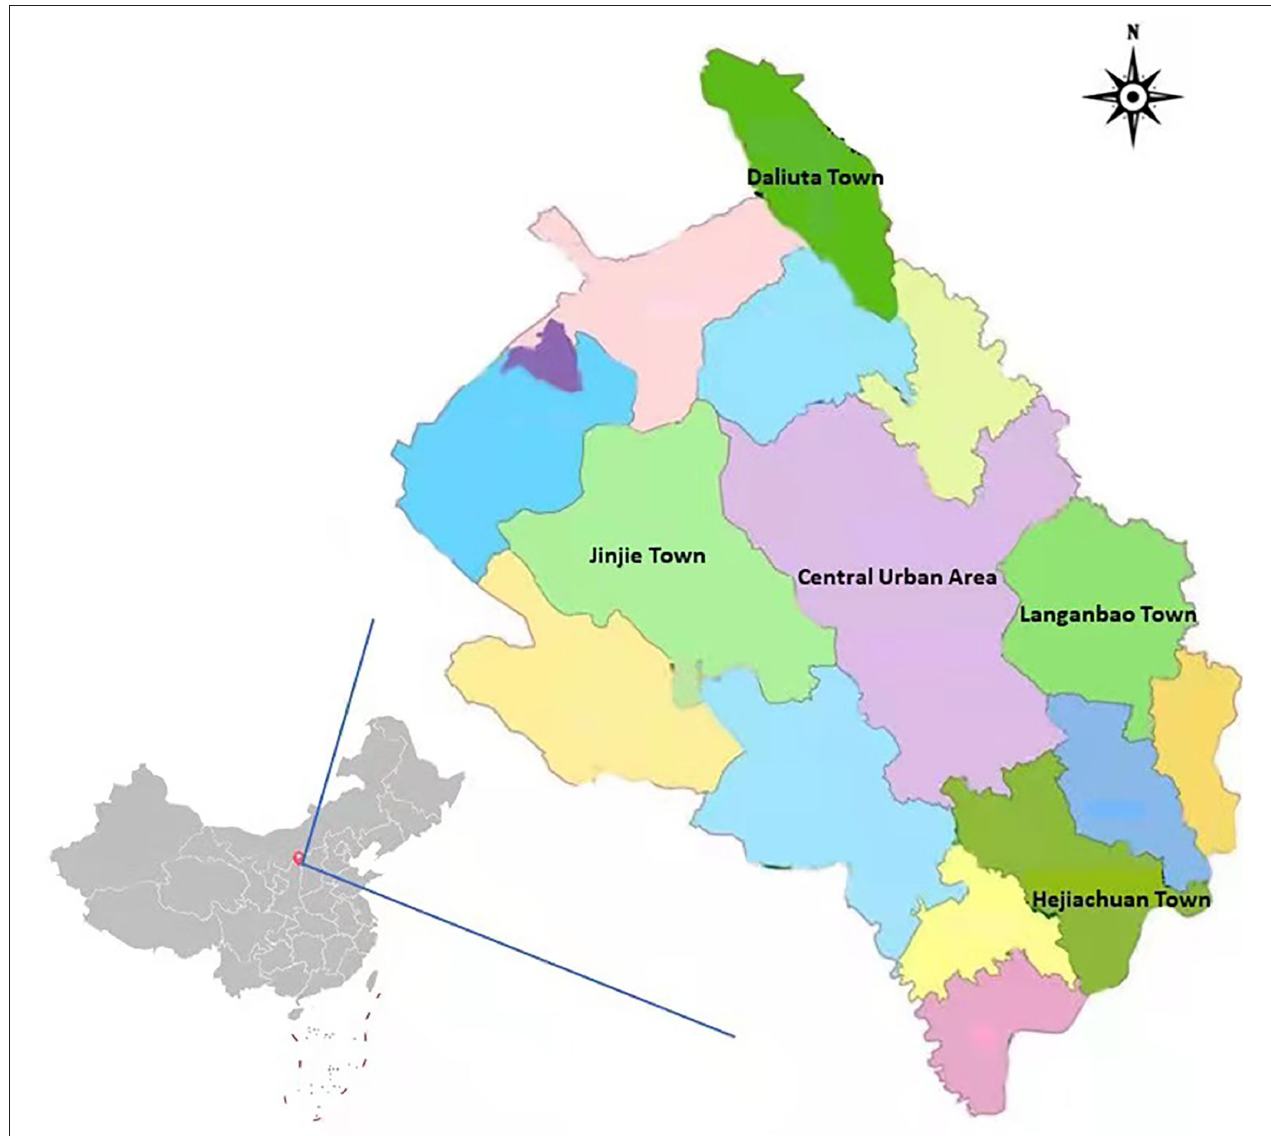
FIGURE 1 | Location of five survey sites in Shenmu